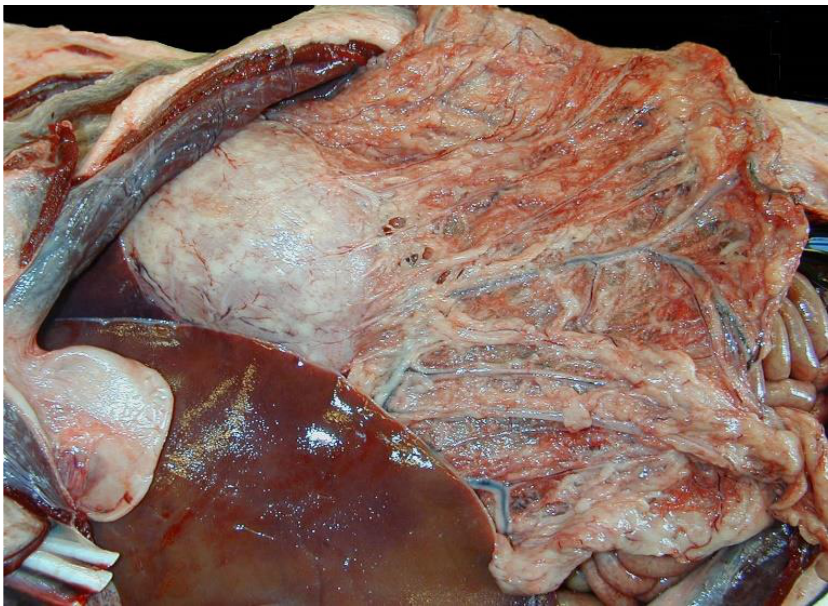
Figure 1. Representative California sea lion with steatitis and polyserositis, peritoneal cavity. The omental adipose is friable, tan, and reddened with congested vessels and firm nodules surrounding the arcuate vasculature. The gastric serosa is overlain by adherent white to pale tan slightly raised plaques. The liver margins are sharp and covered with a thin layer of tan friable material.